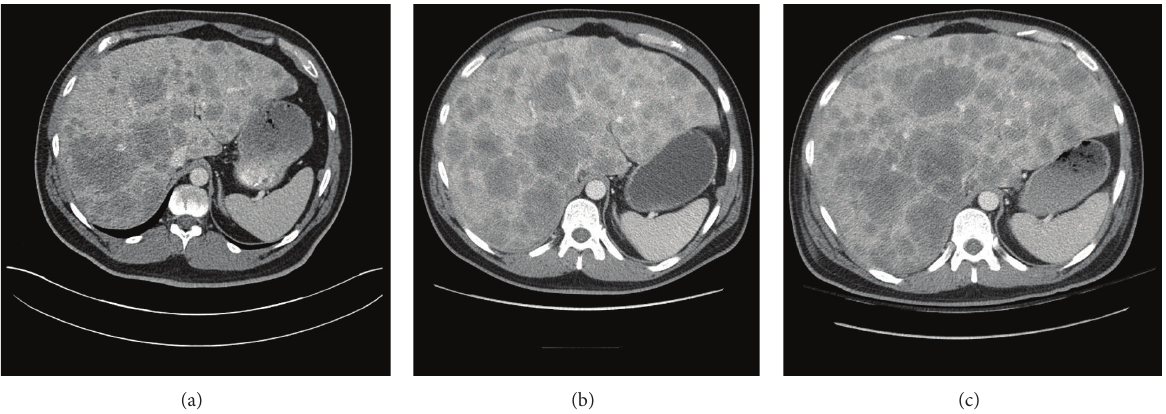
Figure 2: Case 1: CT scan of the abdomen showing rapid progression in both size and number of the previously noted innumerable liver metastases in a patient with mCRC: (a) day 0, (b) day 10, and (c) day 18.